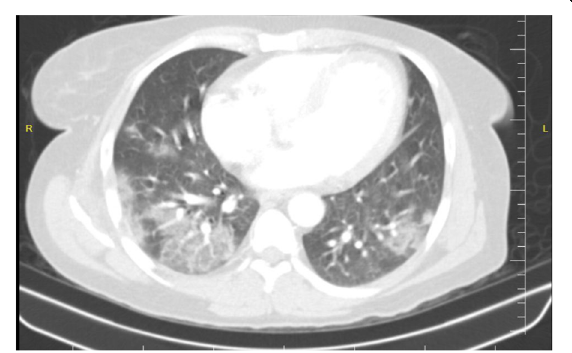
Fig. 1 An axial chest CT from a 47-year-old woman with COV İ D-19 pneumonia. Non-contrast-enhanced chest CT image showing multiple peripheral ground-glass opacities distributed in the